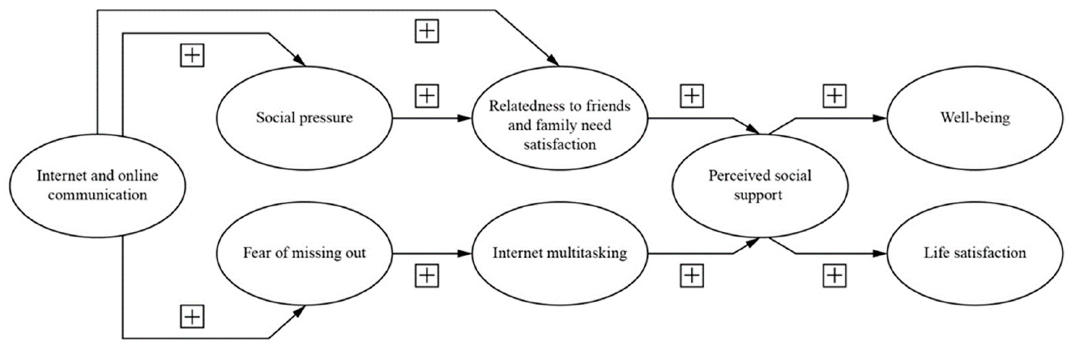
Figure 1. Research model and